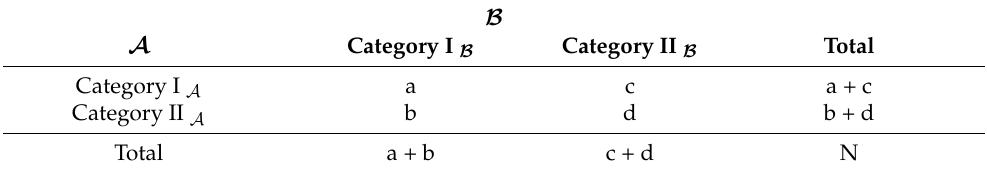
Table 2. Structure of tables of contingency with synthetic